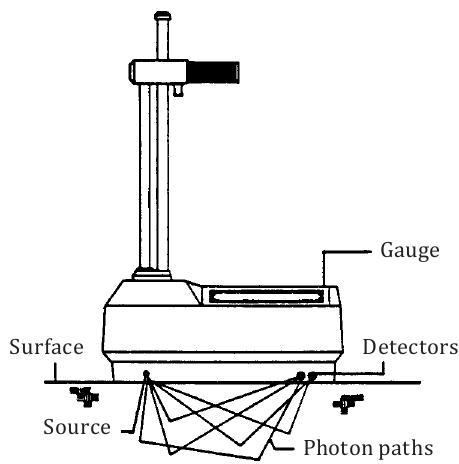
Source Figure 1. Nuclear density gauge operation scheme